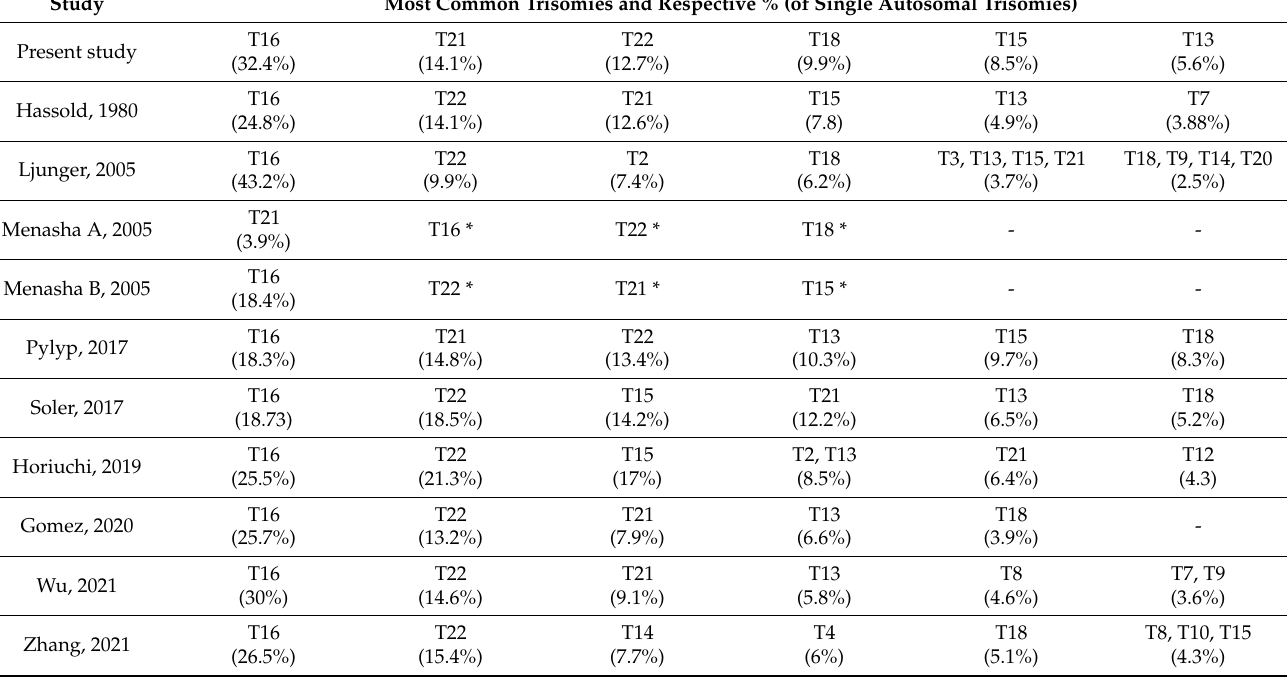
Table 6. Relative frequency of the 6 most common single autosomal trisomies in previous studies and in the present series. All data adjusted to the terms of the present